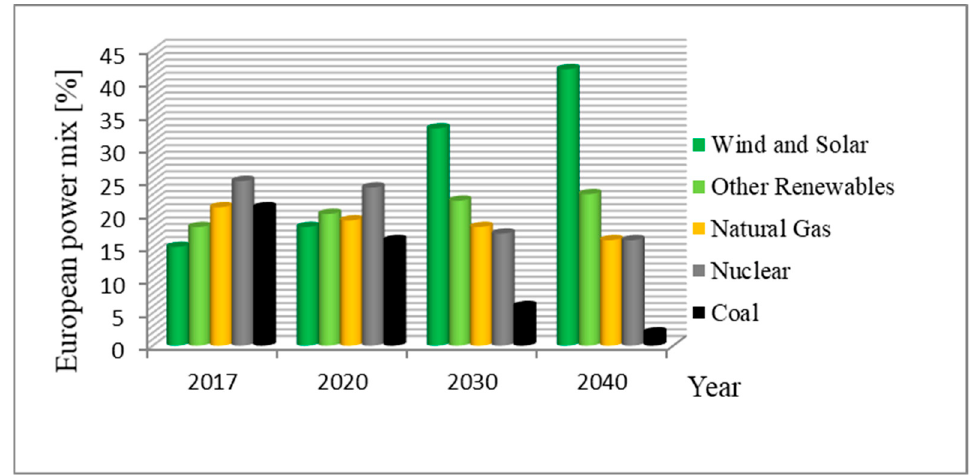
Figure 5. Dynamics of energy mix structure of European energy transition (2017–2050), based on [118].